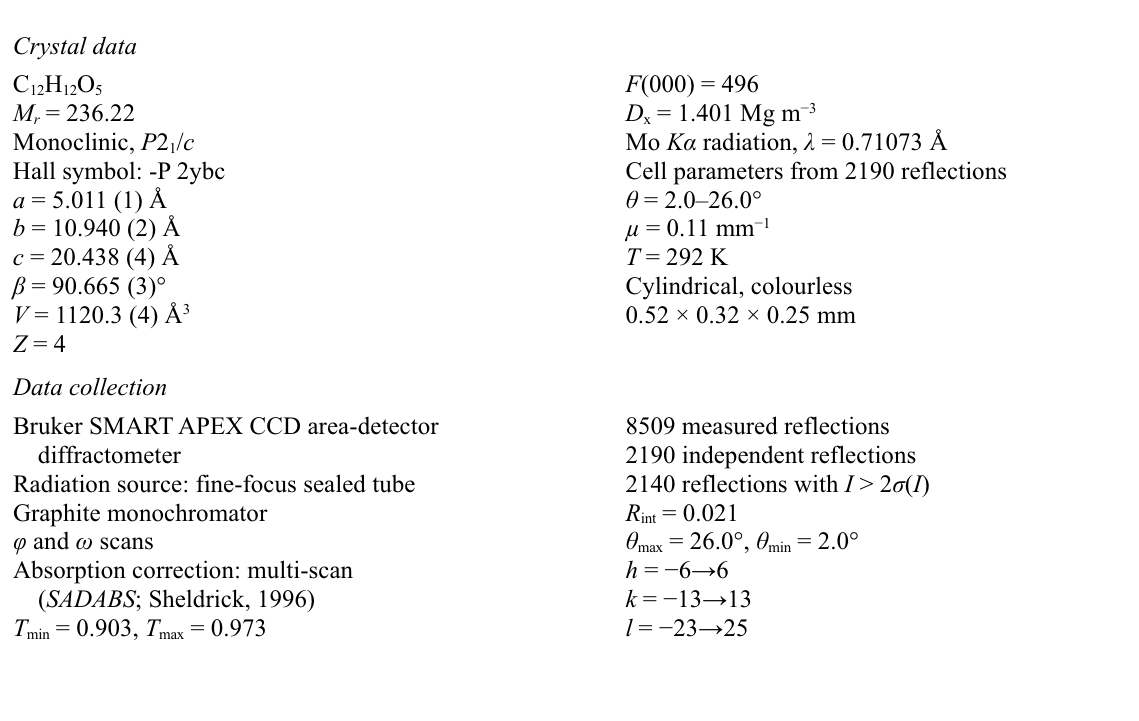
Figure 2 Packing diagram of (I) viewed down the c axis. The dotted lines indicate intermolecular O—H···O interactions. 3-(4-Methoxyphenyl)pent-2-ene-1,5-dioic